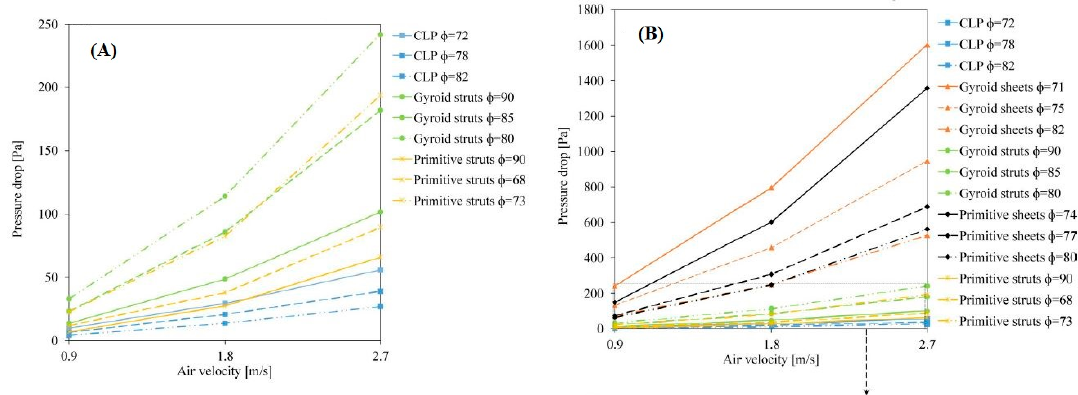
Figure 13. Pressure drop test according to the experiment design for ( A ) sheet-based substrates and ( B ) strut-based substrates for primitive, gyroid and CLP Structures. Reproduced with permission from [168]. Copyright The American Ceramic Society, 2019. from [168]. Copyright The American Ceramic Society,